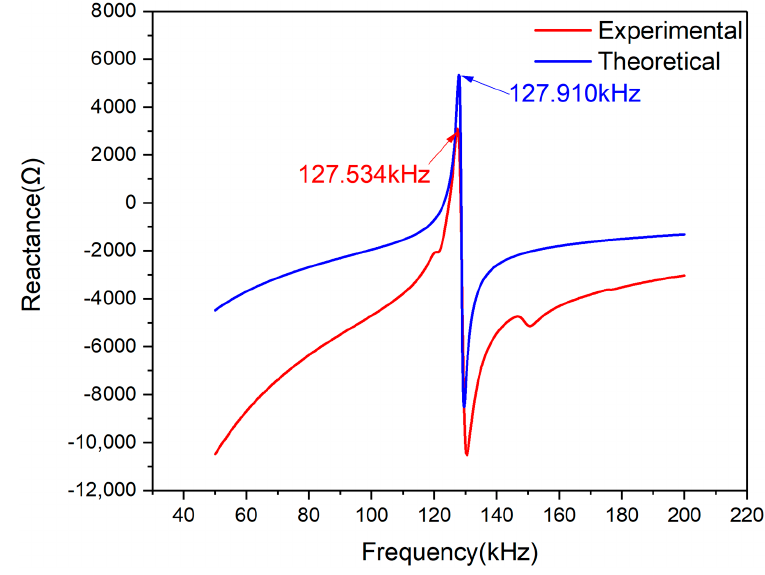
Figure 12. Experimental and theoretical reactance plots comparison of PZT#2.